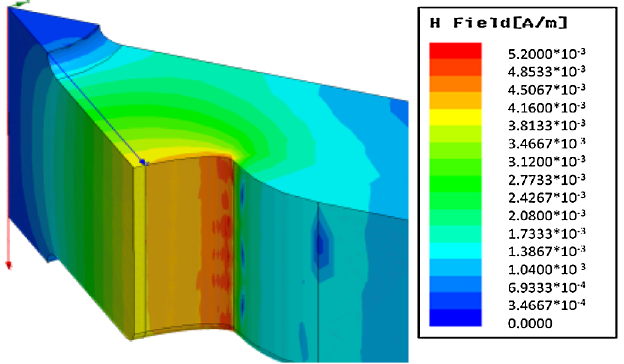
FIG. 7. Cutaway view of 1 = 8 of a cell of the multicell TW structure showing its surface magnetic field distribution.